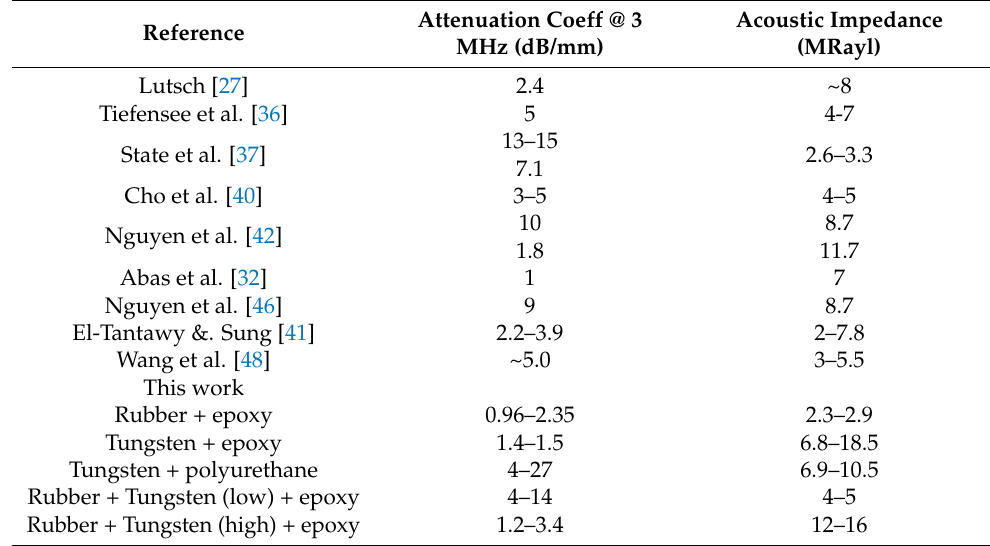
Table 13. Comparative of attenuation coefficient and acoustic impedance values in particle-loaded polymer